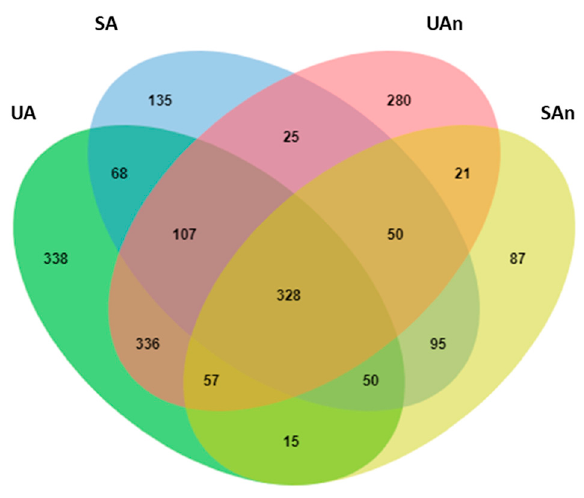
Figure 4. Venn diagram of shared and unique bacterial species in the different burial set-ups dur-